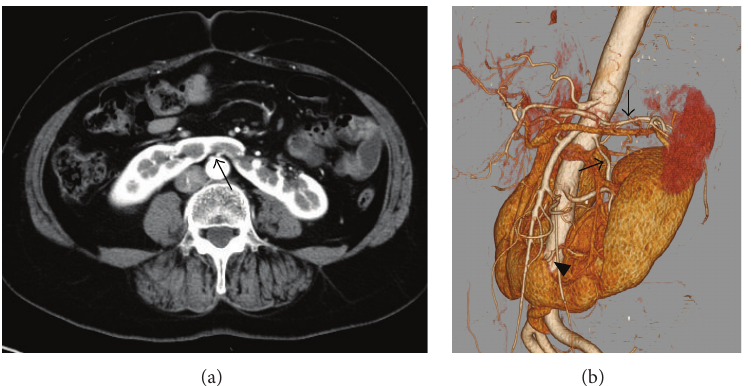
Figure 1: (a) Preoperative donor CT images with contrast enhancement showed the isthmus of the horseshoe kidney and an artery from the aorta supplying the isthmus (arrow). (b) Three-dimensional reconstruction of the CT scan of the donor revealed various blood vessels supplying the horseshoe kidney. Two left renal arteries (arrows) supplied the upper and middle poles of the left kidney and two aortic branches (arrowheads) supplied the isthmus.